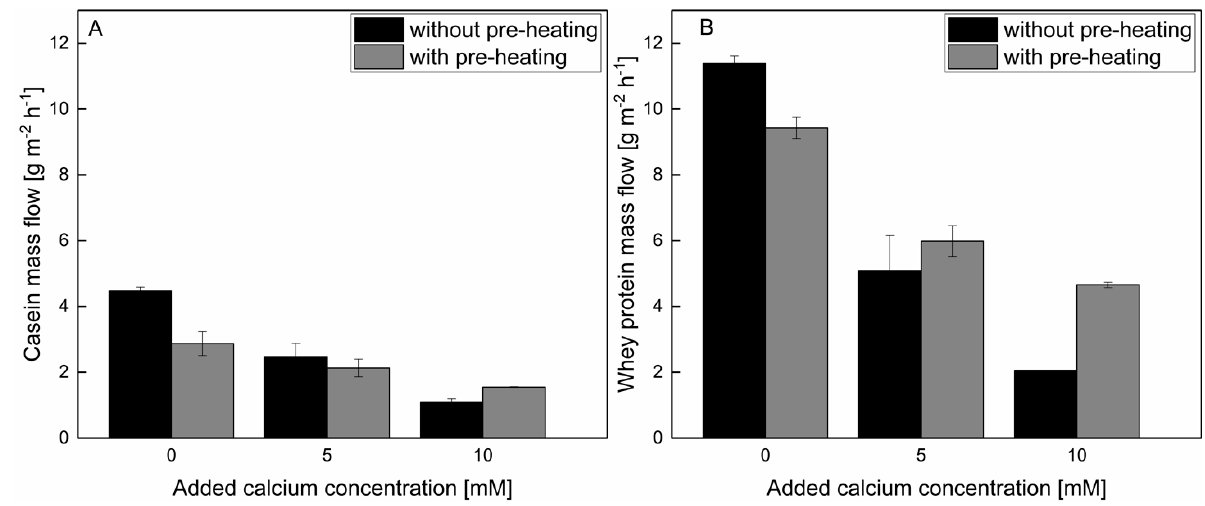
Figure 5. ( A ) Casein and ( B ) whey protein mass flow of a filtration of skim milk with 0–10 mM added calcium, with and without prior pre-heating.